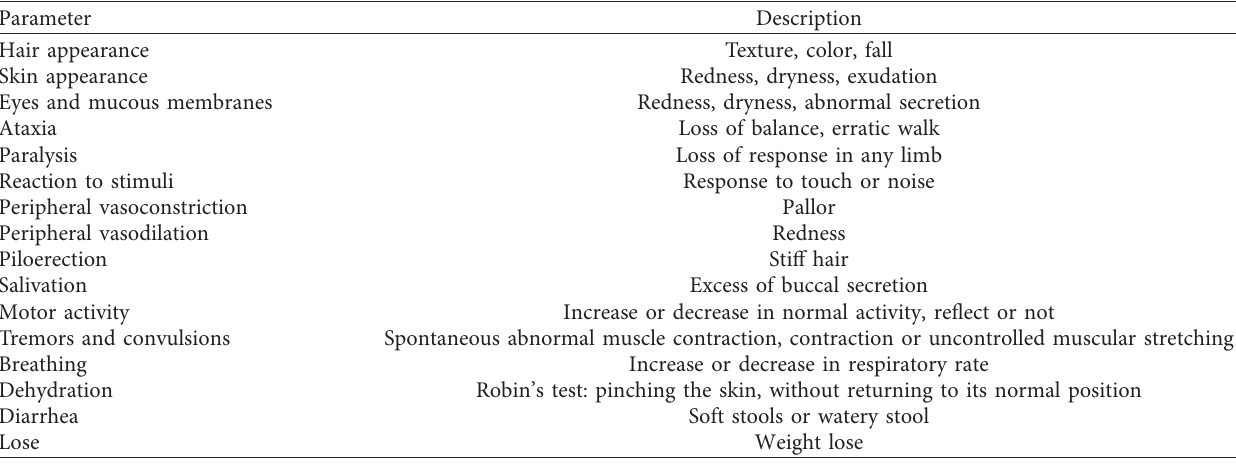
Table 3: Parameters of animal health evaluation.